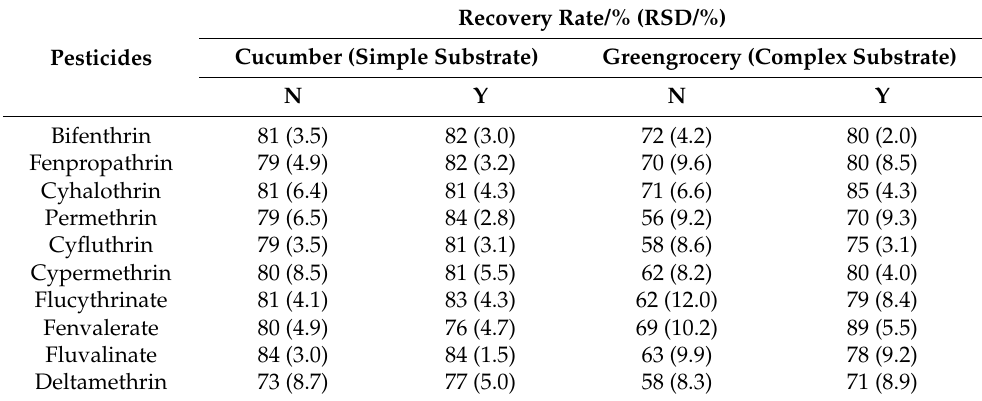
Table 2. Influence of filtration on the recovery rate of pyrethroid pesticides. Recovery Rate/% (RSD/%) Cucumber (Simple Pesticides